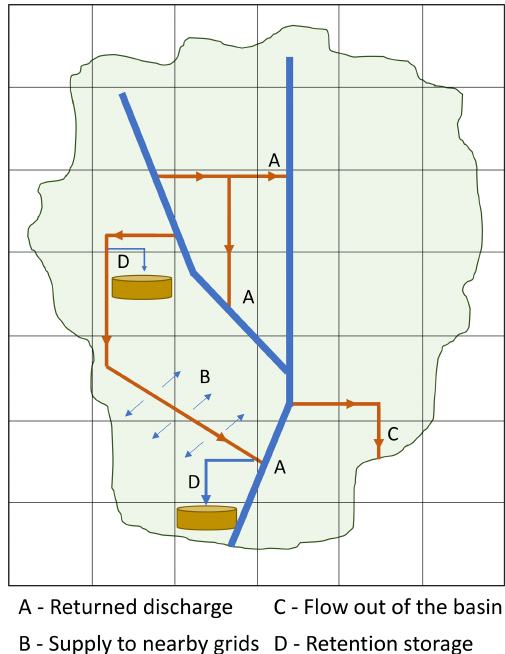
Figure 2. Schematic diagram of the four major components of the diverted canal flow. The green area denotes the river